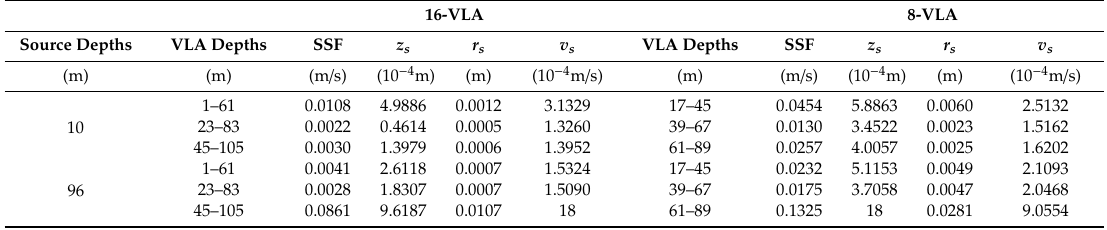
Table 5. Time-average RMSE of EnKF for the source-vertical line array (VLA) deployment configurations. 16-VLA 8-VLA Source